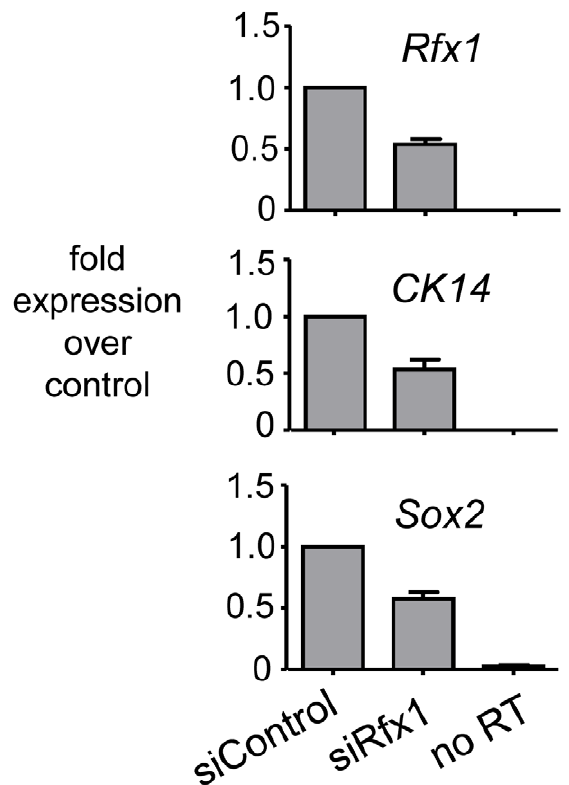
Figure 6. Knock-down of Rfx1 causes diminution of CK14 and Sox2 expression. The panels show qRT-PCR data of RNA from MEK cells treated either with control siRNA, siRNA to Rfx1 , or the latter but without addition of RT to the reaction. The Rfx1, CK14, and Sox2 genes were investigated. The data indicate that diminution of Rfx1 causes a similar diminution of the CK14 and Sox2 expression in esophageal epithelial cells.